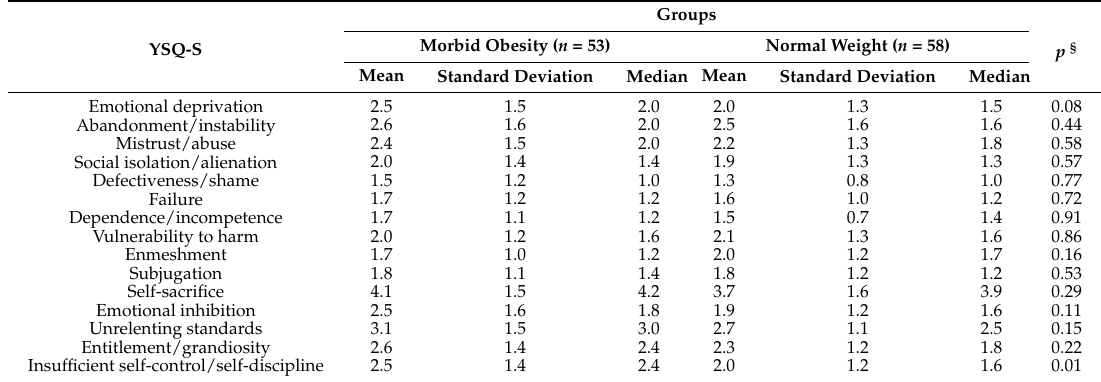
p § Morbid Obesity ( n = 53) Normal Weight ( n = 58)